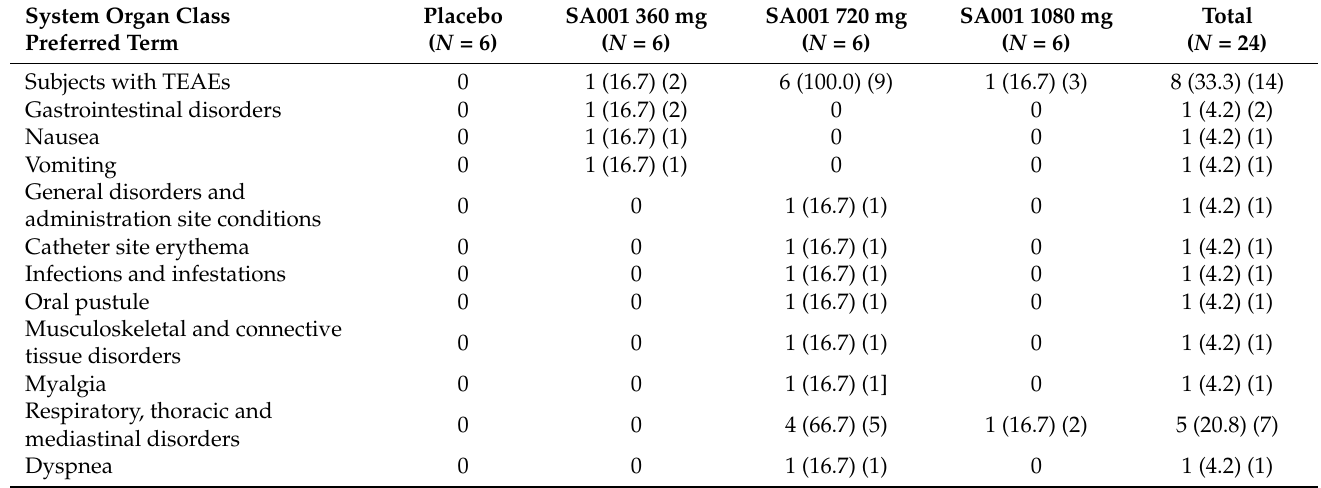
Table 4. Summary of treatment-emergent adverse events (TEAEs) by systemic organ class and preferred term after multiple oral administrations of